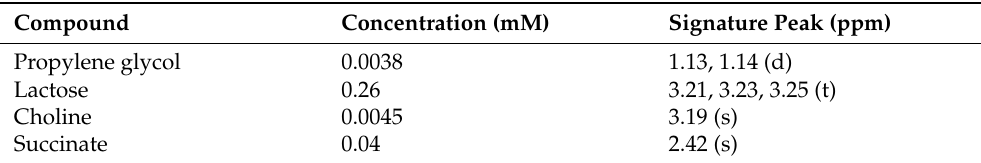
Table 2. qNMR of the compounds identified with Chenomx software using TSP at 0.1% as refer- ence compound and indicating the signature peaks used for the quantification of each compound. (s) = singlet, (d) = doublet and (t) = triplet.